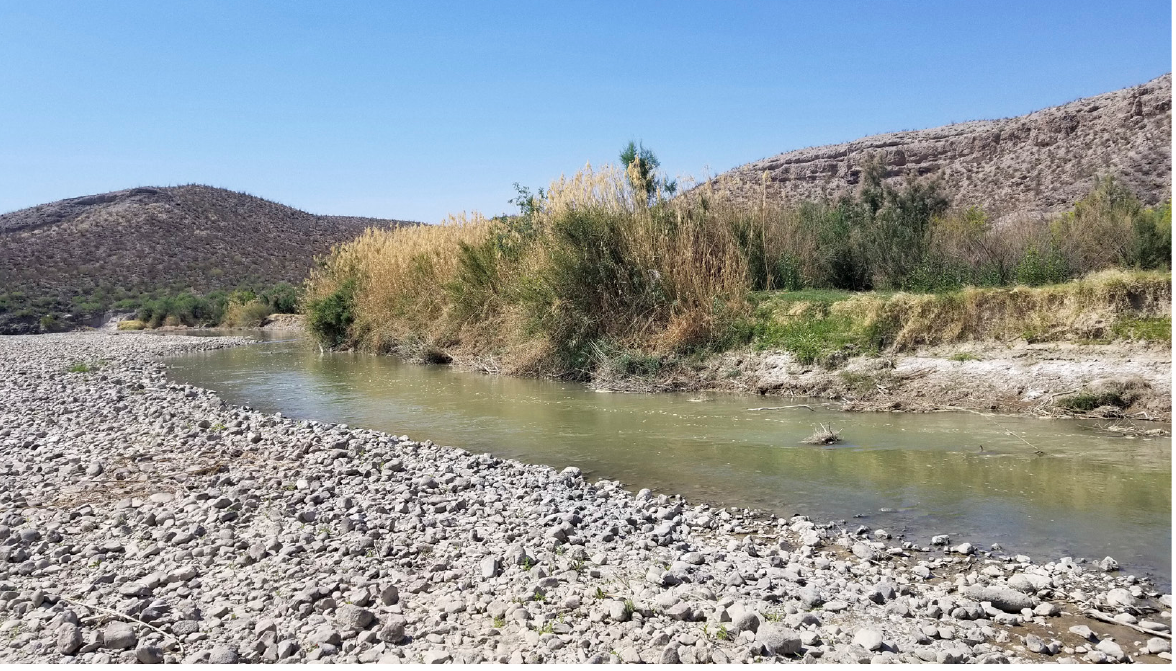
Figure 3. Rio Grande at the confluence with Alamito Creek (Presidio Co., Texas, 16 April 2018). The dry bed of Alamito Creek, representing the northern (USA) shoreline, is shown in the foreground.